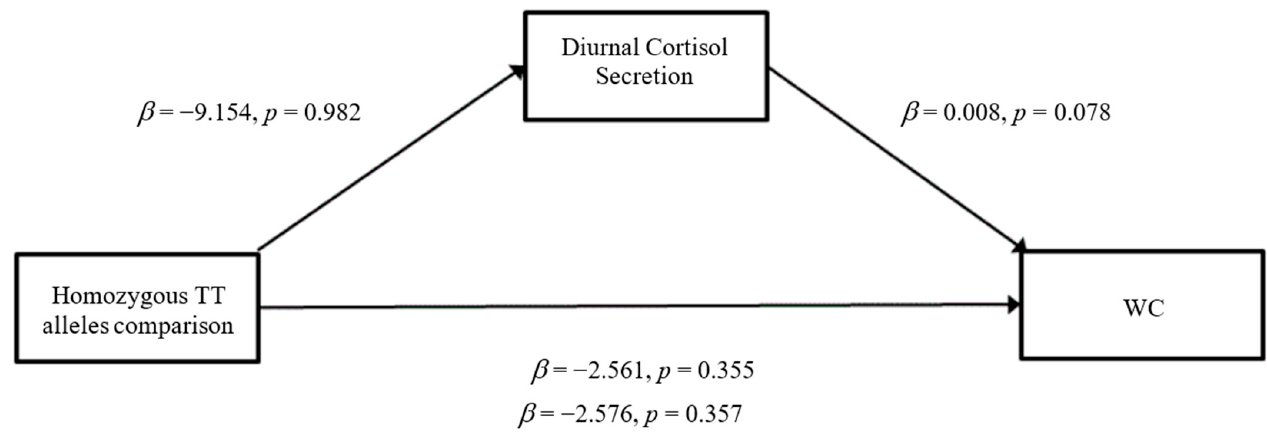
Figure 6. Mediation model for Homozygous TT alleles comparison with WC through the pathway of diurnal cortisol secretion (Model 4).